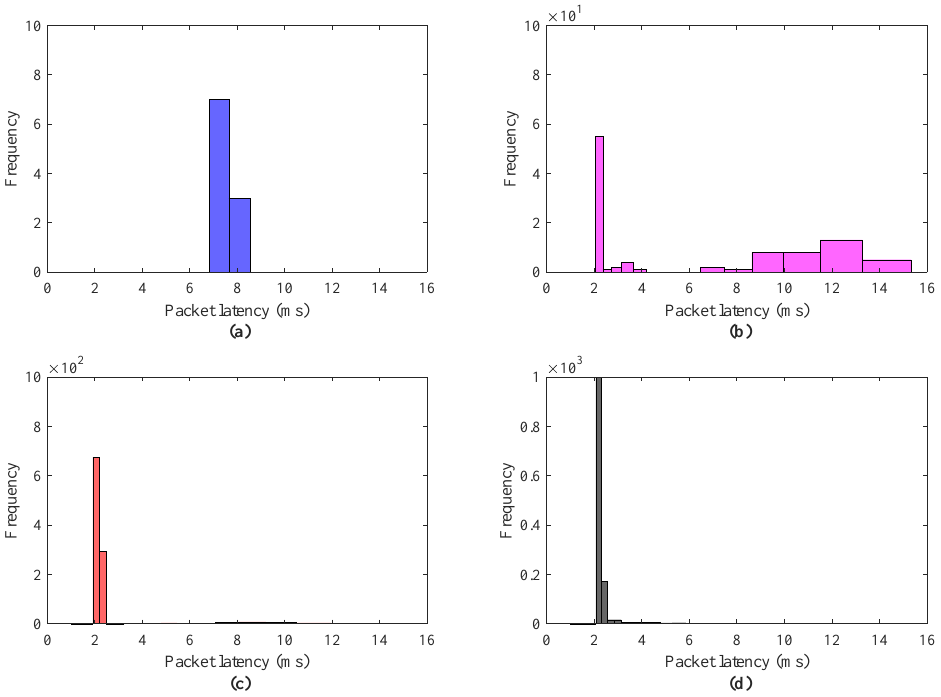
Figure 13. Packet latency histogram for scenario II real time haptic-driven remote operation; ( a ) data packets = 10, ( b ) data packets = 100, ( c ) data packets = 1000, ( d ) data packets =